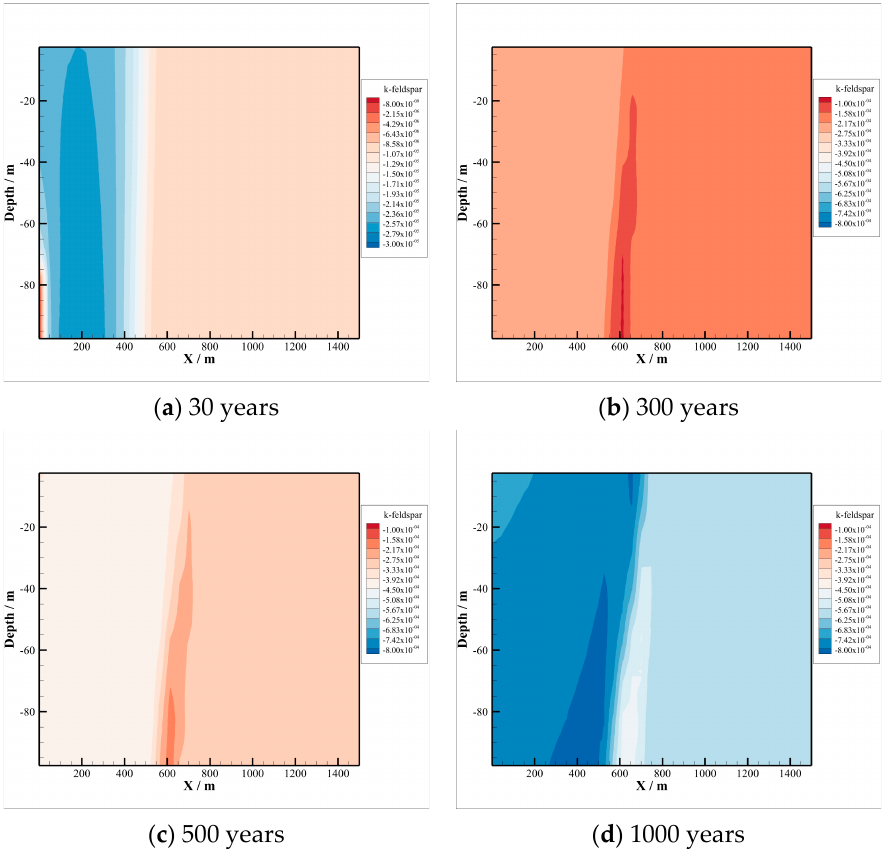
Figure 5. K-feldspar